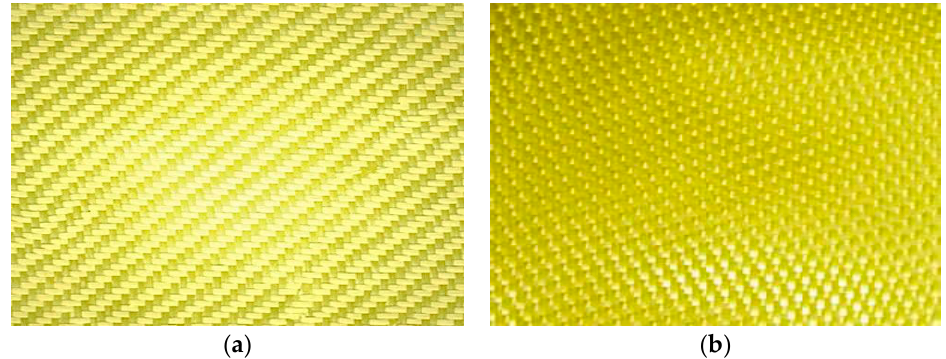
Figure 1. Aramid-fiber-reinforced polymer. ( a ) Front side; ( b ) Back side.